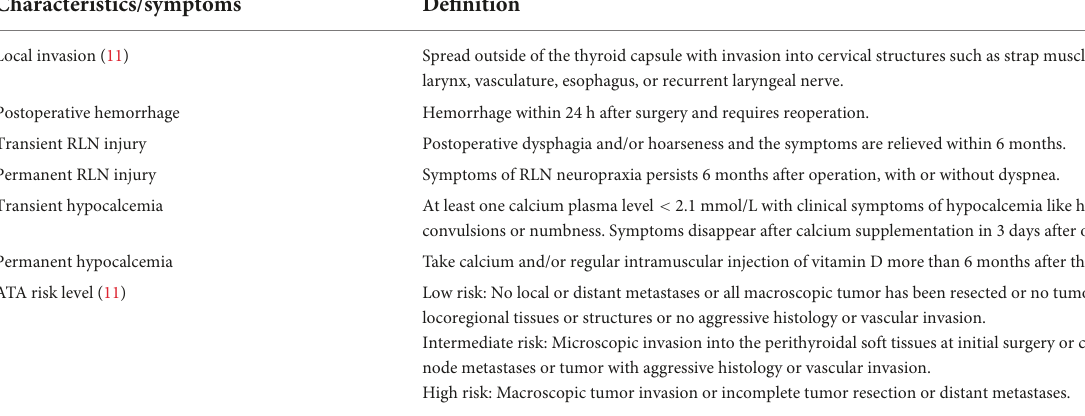
TABLE 1 Definitions of clinical characteristics and